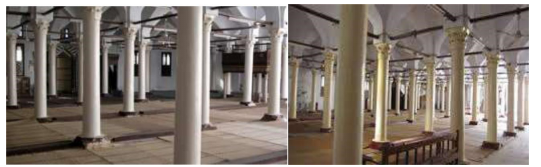
Figure 10. Zaghloul Mosque